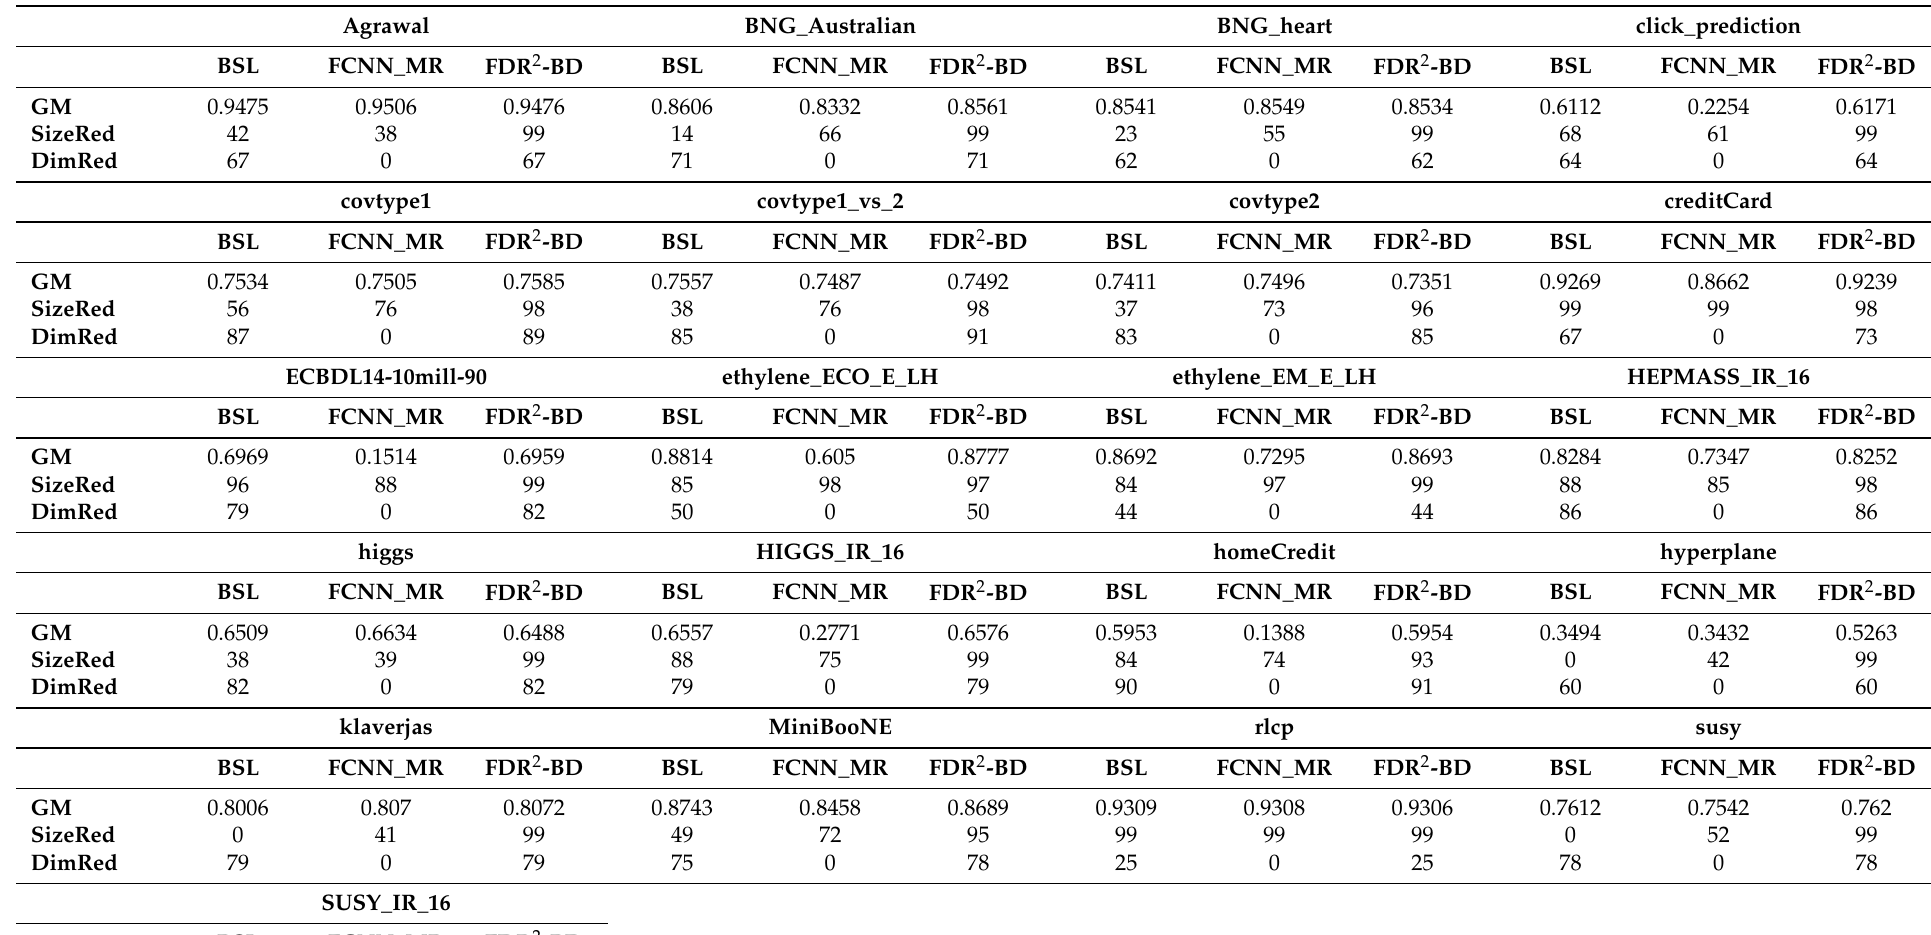
Table 6. Data condensation details and performance